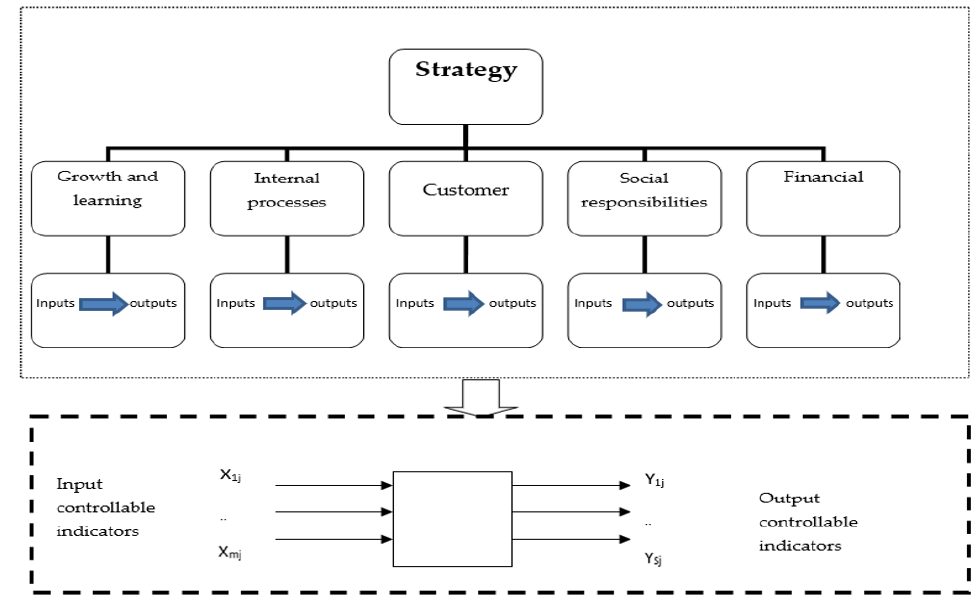
Figure 5. Generalized integrated model of the scorecard and data envelopment analysis .